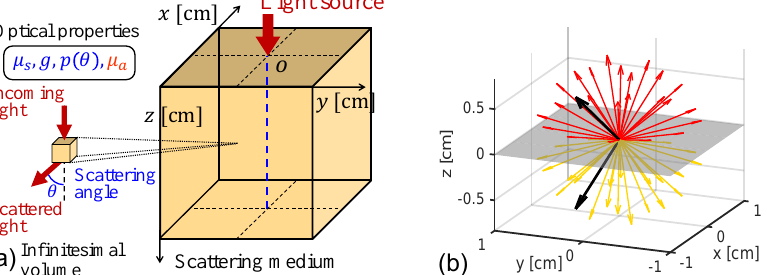
Figure 1. ( a ) Scattering medium, which models the alumina suspension for the RTT. The optical properties are defined in an infinitesimal volume of the medium. The light source (the red arrow) is incident on the origin. The blue dotted line represents positions where the fluence rates are calculated. ( b ) Outward and reflected directions (red and yellow arrows) at z = 0 surface (gray color) based on the LSE quadrature set. Black arrows denote outward, and corresponding reflected